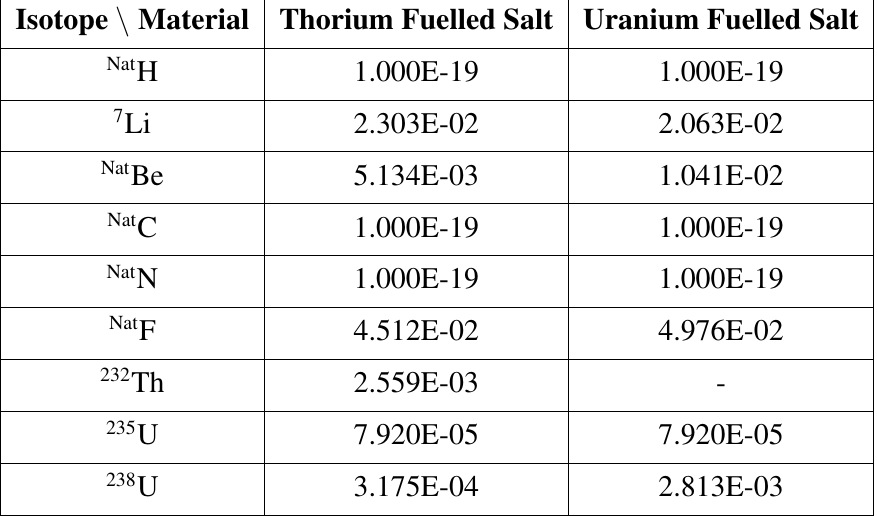
Table III: Atomic densities of thorium & uranium fuels given in units of atoms/barn cm